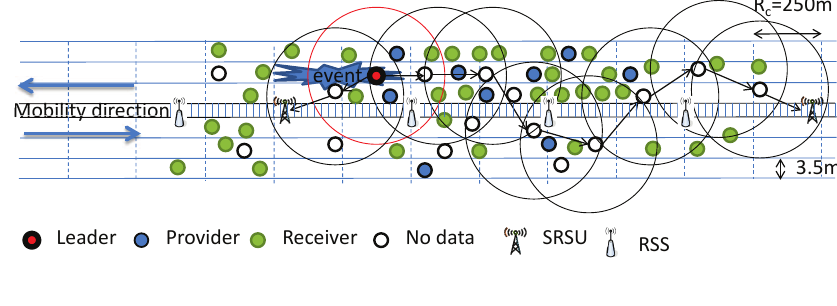
Figure 11. Selection of the next Leader when vehicles move along the opposite direction.